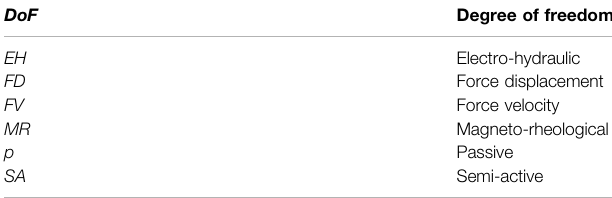
TABLE 1 | Acronym de fi nitions. DoF EH